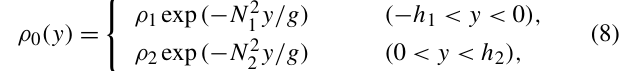
Figure 1. Scheme of the